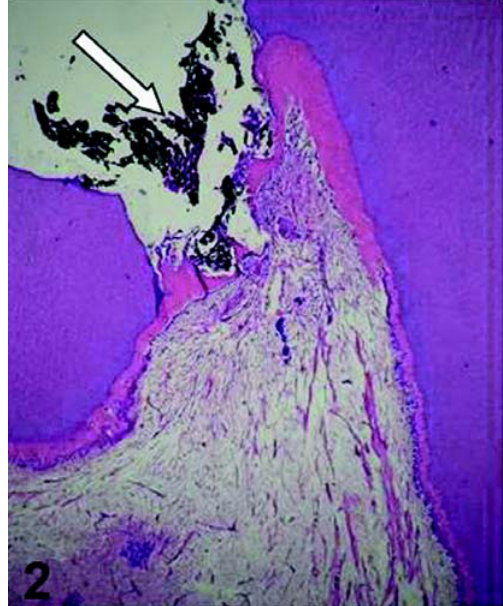
FIGURE 2- Pulp exposure capped with calcium hydroxide (arrow). Observe that 30 days after the pulp therapy, a partial hard tissue barrier was formed adjacent to the capping agent. HE,